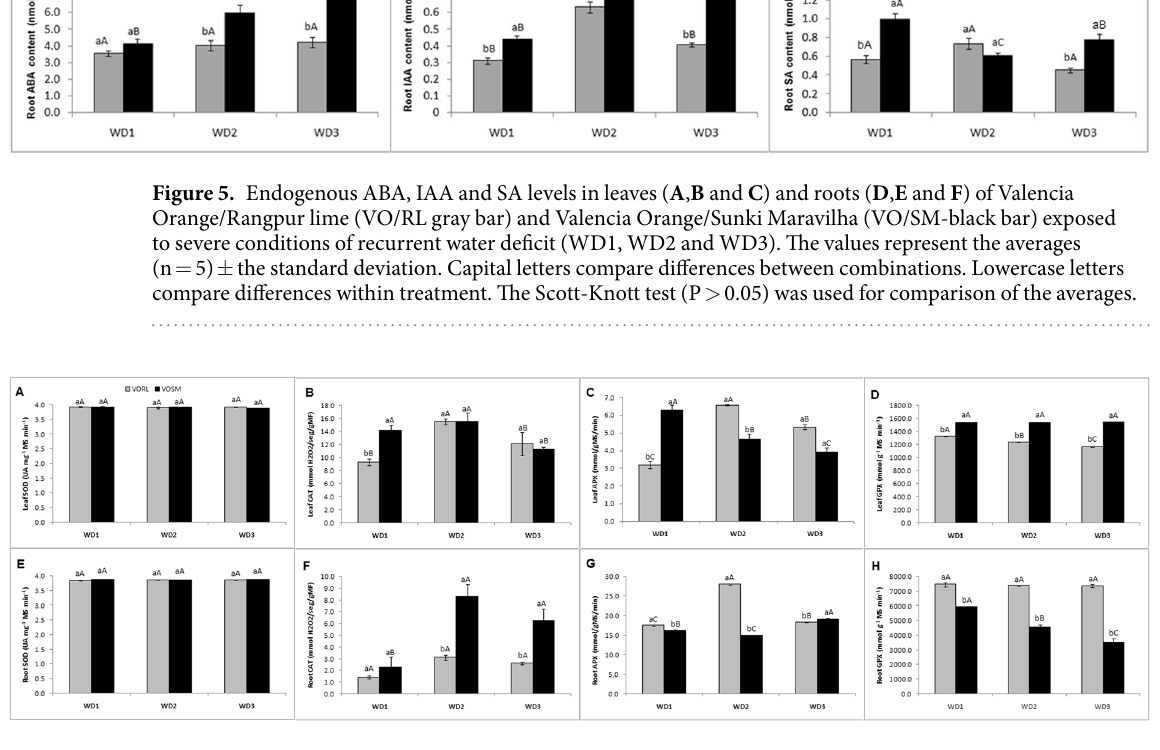
Figure 6. Superoxide dismutase (SOD), catalase (CAT), ascorbate peroxidase (APX), guaiacol peroxidase (GPX) activities in leaves ( A , B , C and D ) and roots ( E , F , G and H ) of Valencia Orange/Rangpur lime (VO/RL gray bar) and Valencia Orange/Sunki Maravilha (VO/SM-black bar) exposed to severe conditions of recurrent water deficit (WD1, WD2 and WD3). The values represent the averages (n = 3) ± the standard deviation. Capital letters compare differences between combinations. Lowercase letters compare differences within treatment. The Scott-Knott test (P > 0.05) was used for comparison of the